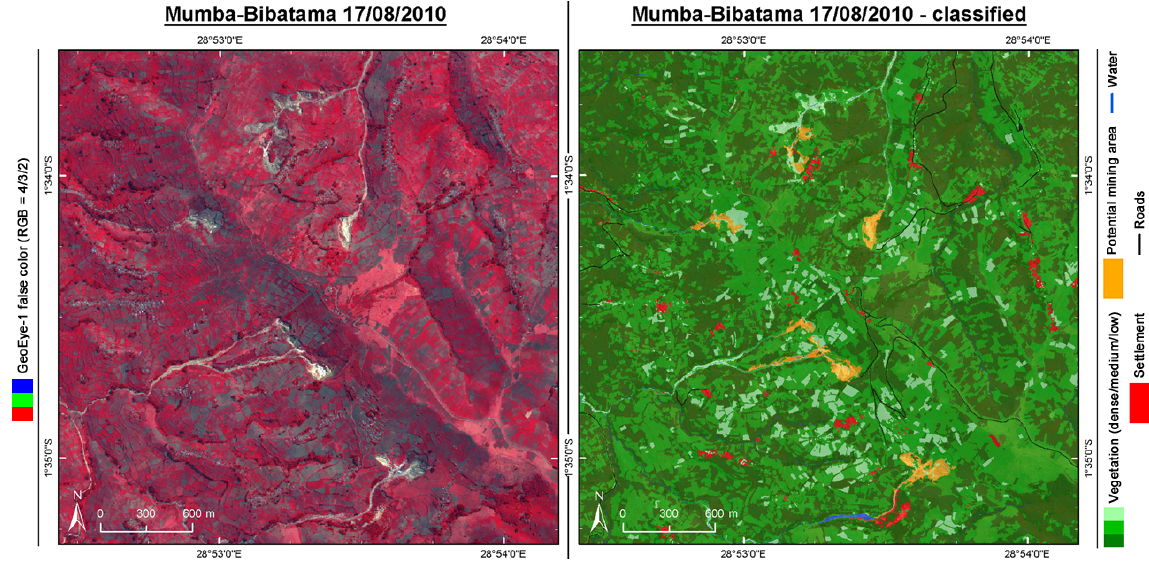
Figure 9. Comparison of unclassified ( left ) and classified ( right ) imagery of